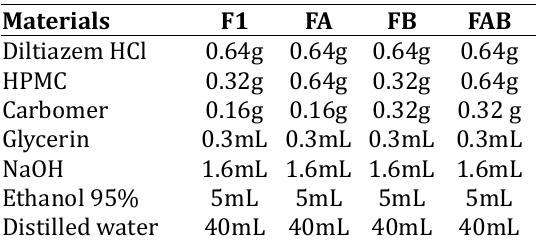
Table I. The composition of the buccal film Diltiazem HCl